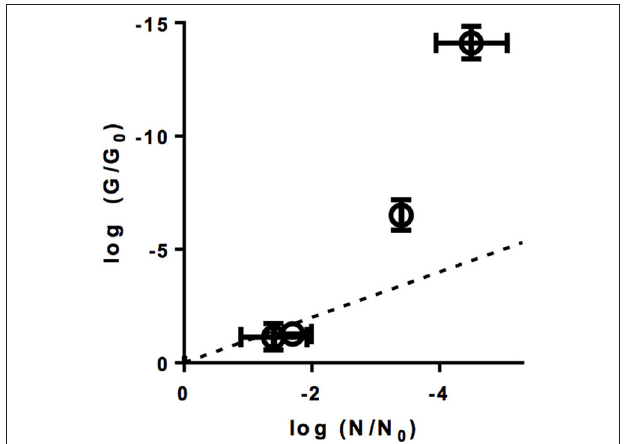
FIGURE 5 | Genome loss log( G/G 0 ) at different levels of inactivation log( N/N 0 ) by ClO 2 . The dotted line represents the 1:1 correlation between inactivation and genome loss. Errors bars represent the MPN enumeration error (horizontal) or the standard deviation associated with G/G 0 (vertical) ( Ku,